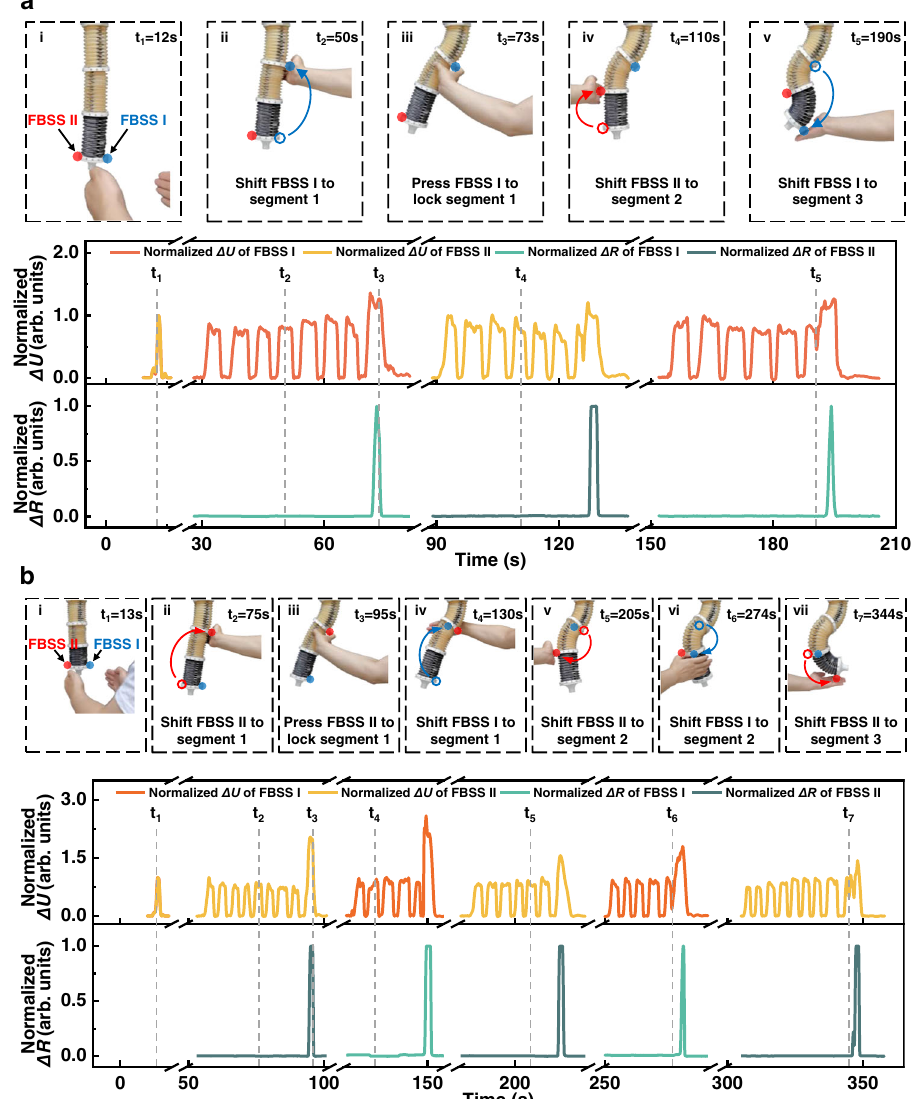
Fig. 7 | Interactive teaching soft manipulator performs complex locomotion basedonthe “ shiftingsensorsandteaching ” method. Thenormalizedtouchless andtactilesignalsofFBSSIandFBSSIIversustime.Theredandbluearrowsineach panel indicate that the user was moving the FBSS from one position to another in